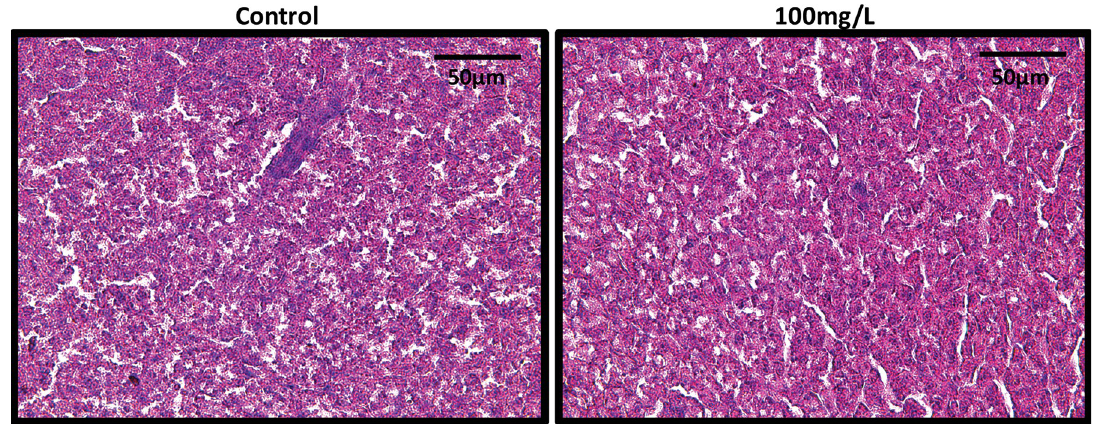
Fig 2. Lipids do not accumulate in zebrafish liver as a result of perchlorate exposure. Lipid droplets (white circles) appear throughout the liver, but neither control zebrafish nor perchlorate-treated zebrafish exhibit elevated lipid accumulation. Slides were stained with hematoxylin and